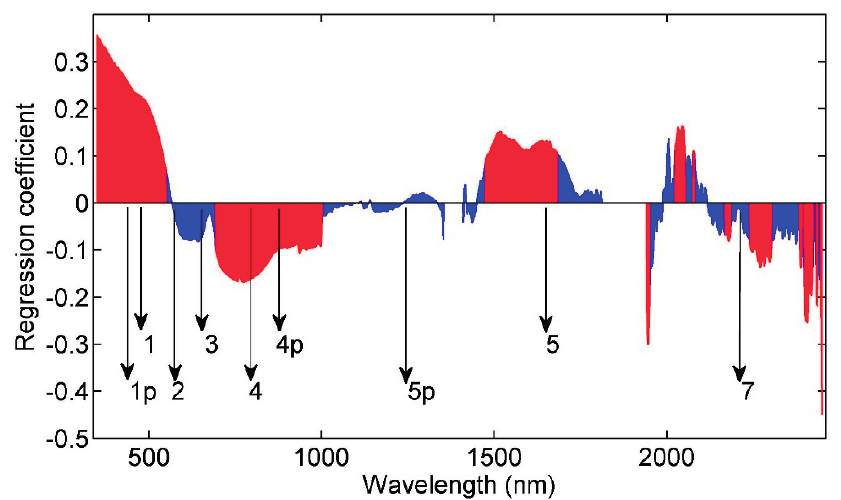
Figure 4. Regression coefficients for the PLSR model obtained from total soil samples and field spectra data. Important wavelengths for soil salinity retrieval are marked in red color. Central wavelengths of ALI bands were denoted with arrows and band